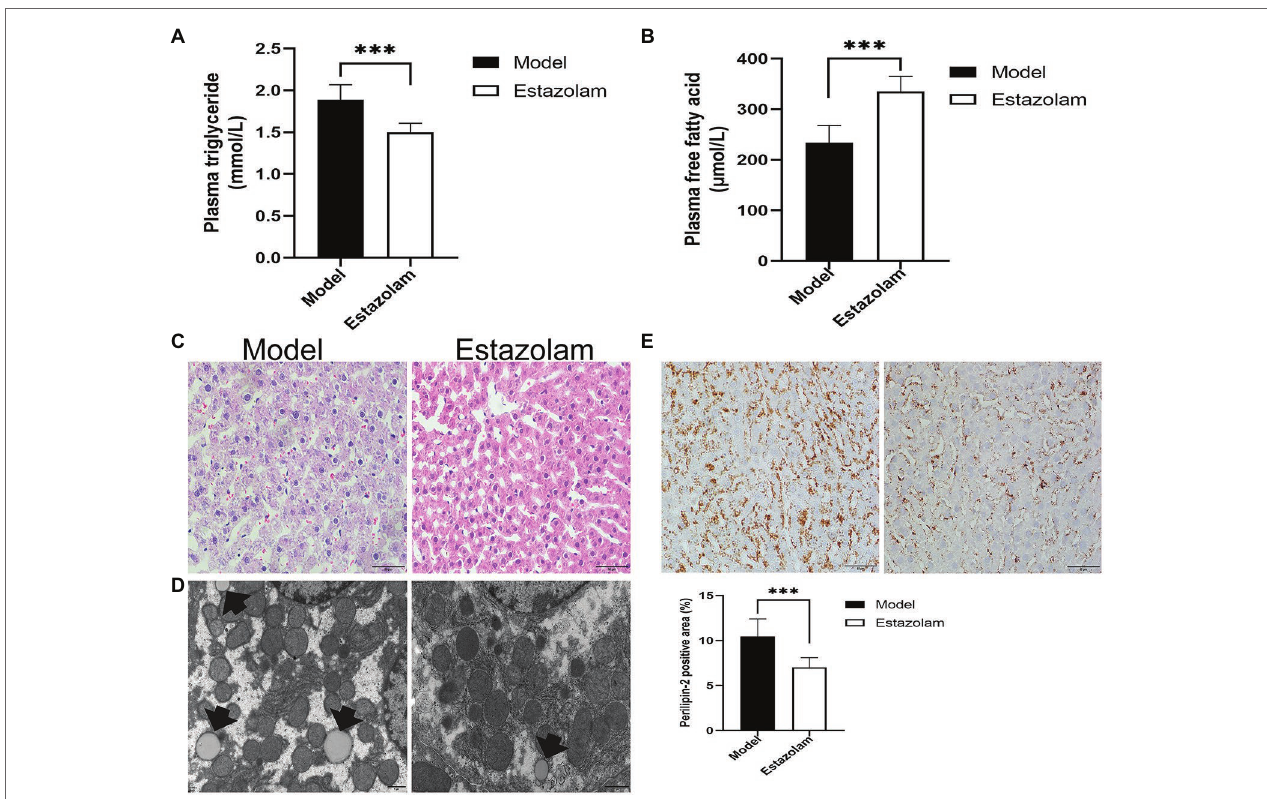
FIGURE 6 | Blood lipids and hepatic steatosis were detected to evaluate the effect of estazolam on fatty liver in insomnia rats. (A) The plasma triglyceride levels. (B) The plasma free fatty acid levels. (C) HE staining (scale bar: 50 μ m). (D) Detection of lipid droplets by TEM (scale bar: 1 μ m). (E) Expression of Perilipin-2 was determined by immunohistochemistry (scale bar: 50 μ m). The results were obtained from two independent experiments and are expressed as the mean ± SD, n = 8 per group, *** p <